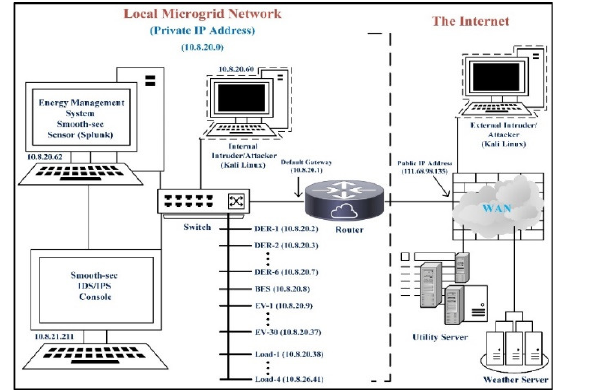
Fig. 9: Proposed Industrial Microgrid Network Topology